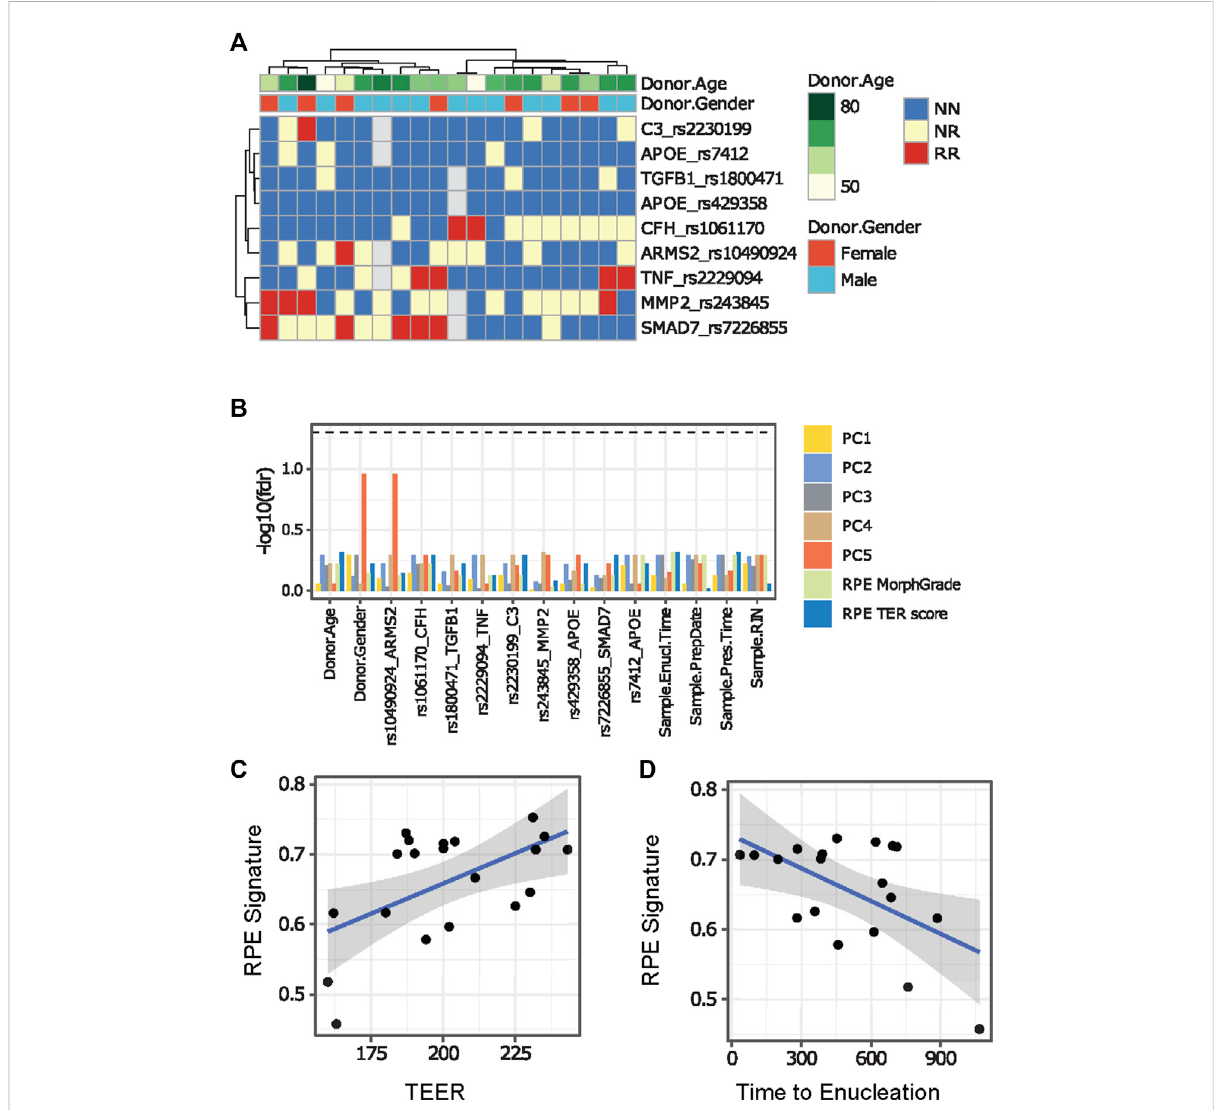
FIGURE 2 Comparison between ahRPE characteristics and RPE physiology. (A) AhRPE were genotyped for high-risk alleles associated with AMD and PVR. (B) Potential technical confounders, donor characteristics, and genomic status of ahRPE samples were compared to RNA-sequencing principal component values and physiological sample traits. (C) AhRPE TEER measurements were graphed against the RPE signature score of each sample. (D) AhRPE sample time of death to enucleation were graphed against their RPE signature score. PC = principal component, NN = homozygous nonrisk, RR = homozygous risk, NR =